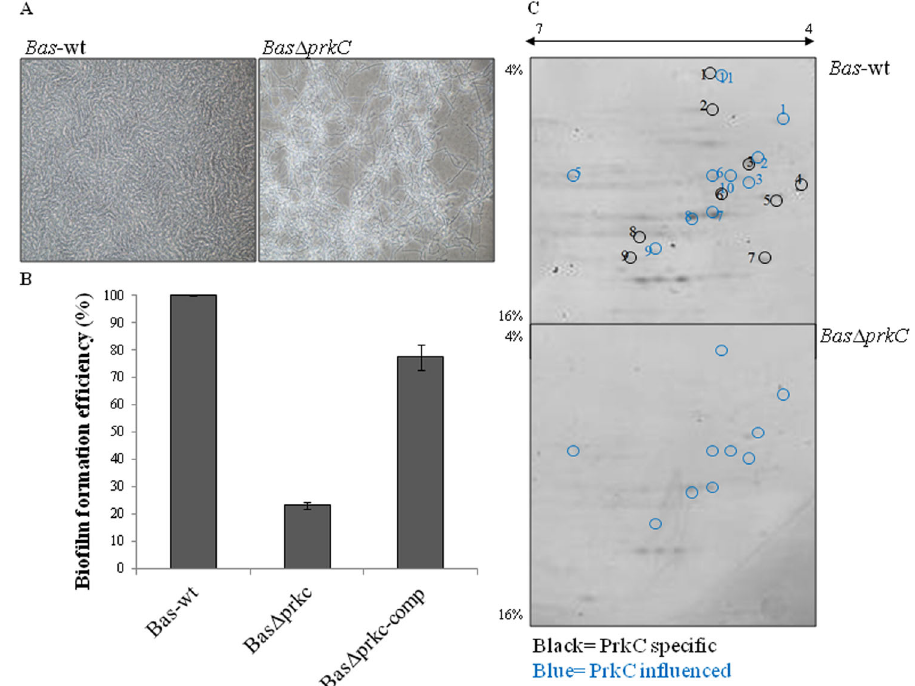
Fig. 1 PrkC-dependent bio fi lm formation in B. anthracis and identi fi cation of in vivo substrates: a Bio fi lm formation in 3-day static culture of Bas -wt and Bas Δ prkC strains after staining with crystal violet as observed under microscope. b Ef fi ciency of bio fi lm formation in Bas -wt, Bas Δ prkC , and complemented Bas Δ prkC strains were calculated by crystal violet assay. Extent of bio fi lm formation was calculated considering Bas -wt as 100%. The experiment was performed thrice and the error bars indicate the standard error (SE) of three independent values. c Bas -wt and Bas Δ prkC lysates were separated by two-dimensional PAGE using 4 – 16% gradient gels and visualized with Pro-Q diamond phospho- speci fi c staining. These proteins were subsequently analyzed by staining the gels with SyproRuby stain (Fig. S1). The more intense ( blue numbered, PrkC-in fl uenced) or unique spots ( black numbered, PrkC-speci fi c) in Bas -wt as compared with Bas Δ prkC were analyzed by mass spectrometry (Table 1). The bands are also encircled with corresponding